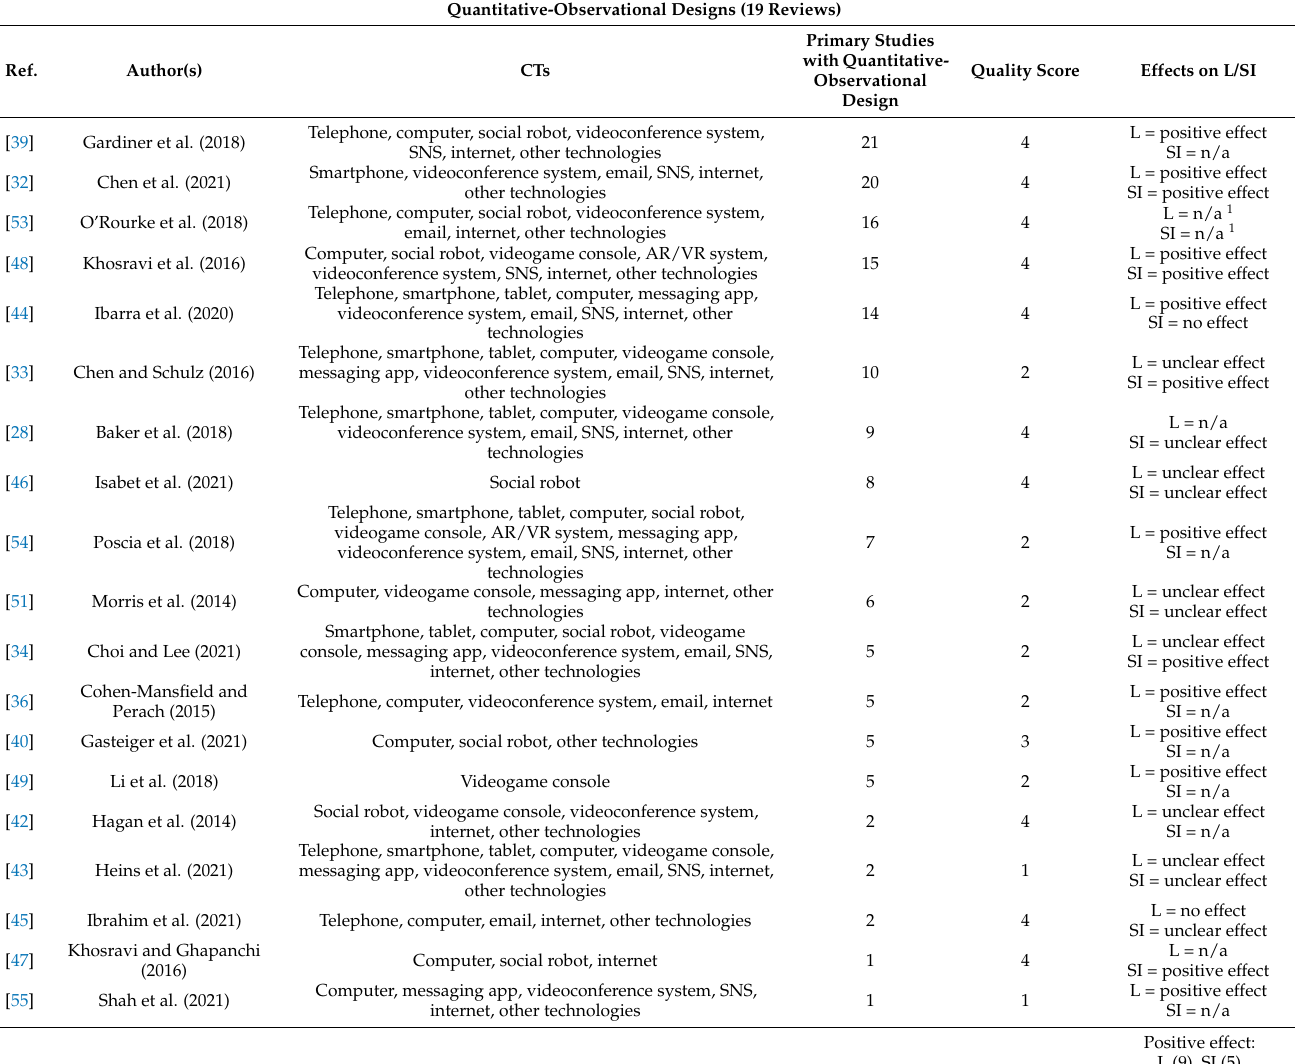
Table 4. Cont. Quantitative-Observational Designs (19